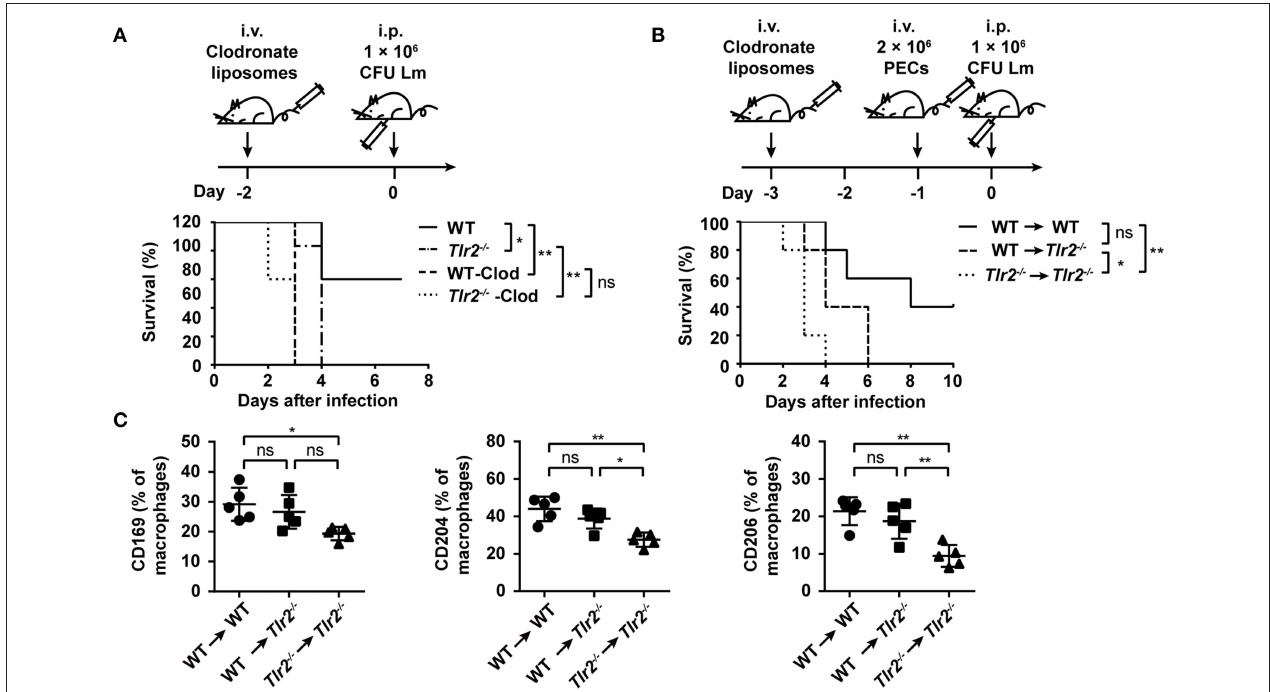
FIGURE 6 | TLR2 plays a critical role in macrophage-mediated anti-Lm responses. (A) WT and Tlr2 − / − mice were treated with clodronate liposomes 2 days before Lm infection. Survival was monitored every day ( n ≥ 5, log-rank test). (B,C) WT or Tlr2 − / − mice were treated with clodronate liposomes to deplete macrophages. Two days later, these mice were transferred with 2 × 10 6 PECs from WT or Tlr2 − / − mice and subsequently infected with Lm the following day. The survival was monitored every day (B) ( n = 5, log-rank test). The expression of CD169, CD204, and CD206 on macrophages (CD11b + F4/80 + ) in the liver was detected by FACS 2 dpi (C) ( n = 5). Data are presented as the mean ± SEM. * p < 0.05, ** p < 0.01.